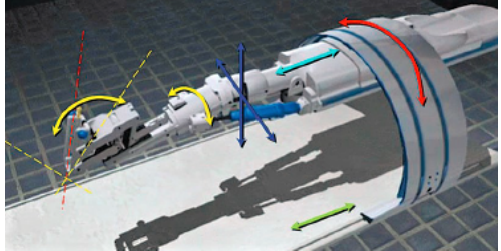
Figure 20. Innomotion system and its corresponding illustrated joint motions